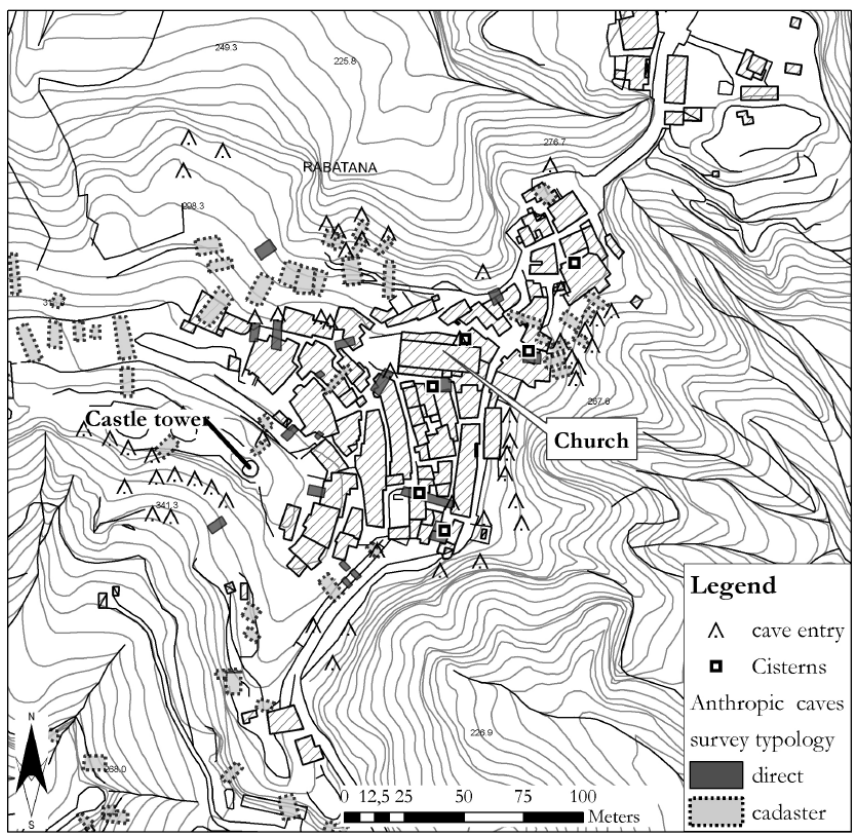
Fig. 5. Distribution of caves surveyed in Rabatana historical